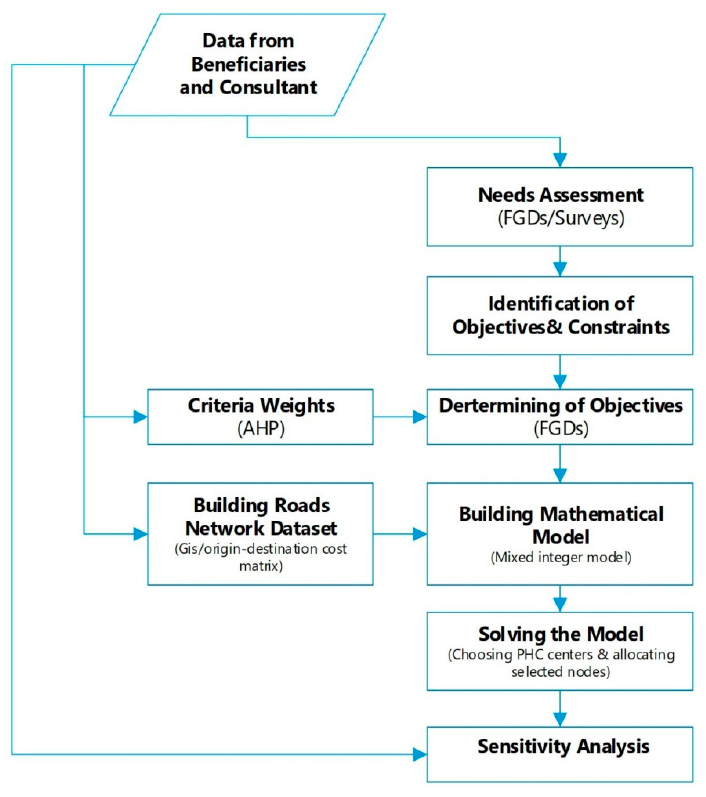
Figure 1. Proposed methodology adopted in the study.